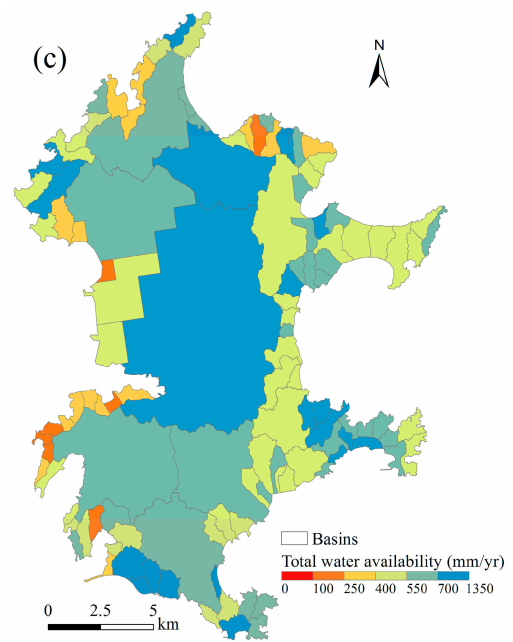
Figure 8. Spatial distribution of ( a ) surface and groundwater availability; ( b ) soil water availability; and ( c ) total freshwater